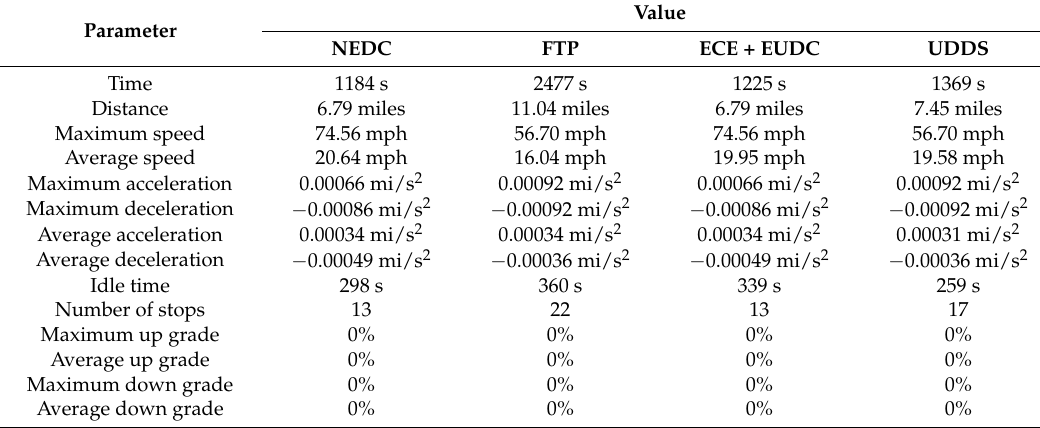
Table 4. Parameters for NEDC, FTP, ECE + EUDC, and UDDS driving cycle. NEDC: new European driving cycle; FTP: Federal Test Procedure; ECE + EUDC: Economic Commission for Europe + Extra-Urban driving cycle; UDDS: urban dynamometer driving